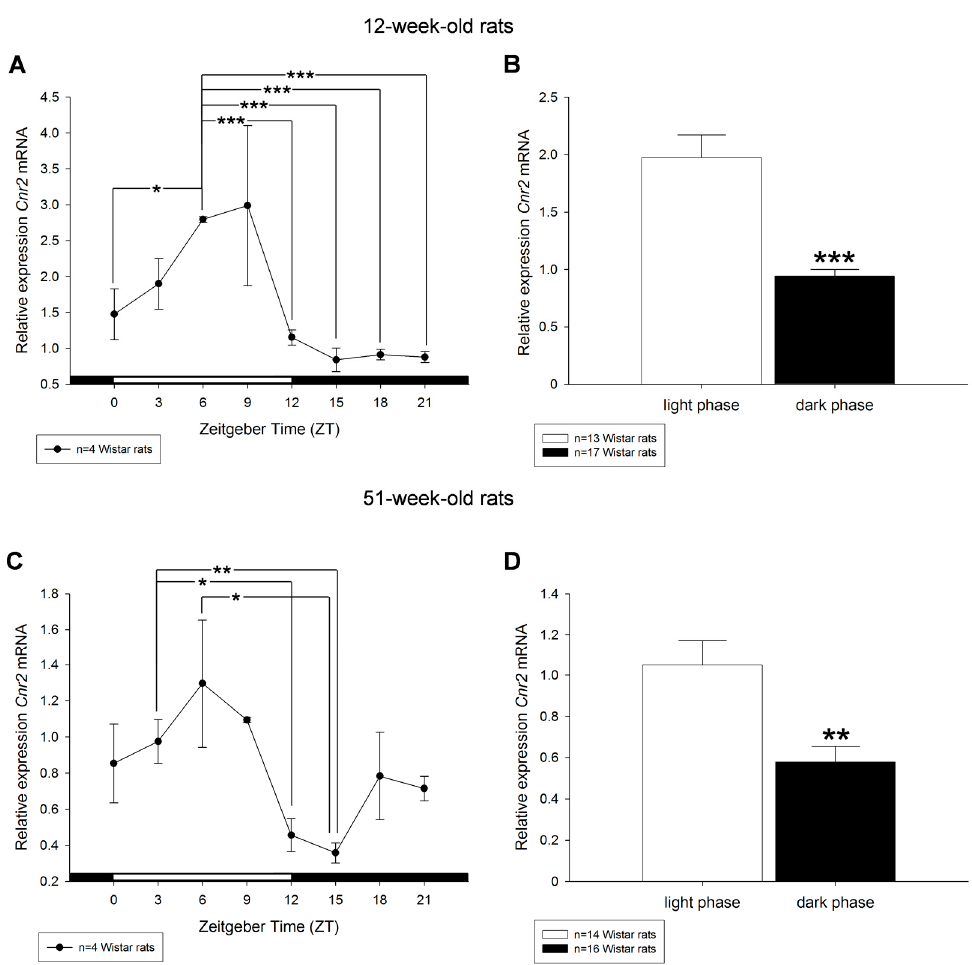
Figure 5. Diurnal profiles of cannabinoid receptor Cnr2 mRNA expression in liver of 12-week-old ( A ) and 51-week-old ( C ) rats are shown. Diurnal differences were analyzed by Mann–Whitney test; * p < 0.05, ** p < 0.01, *** p < 0.001. Values of light phase as well as those of dark phase are summarized for Cnr2 mRNA in 12-week-old ( B ) and 51-week-old rats ( D ).